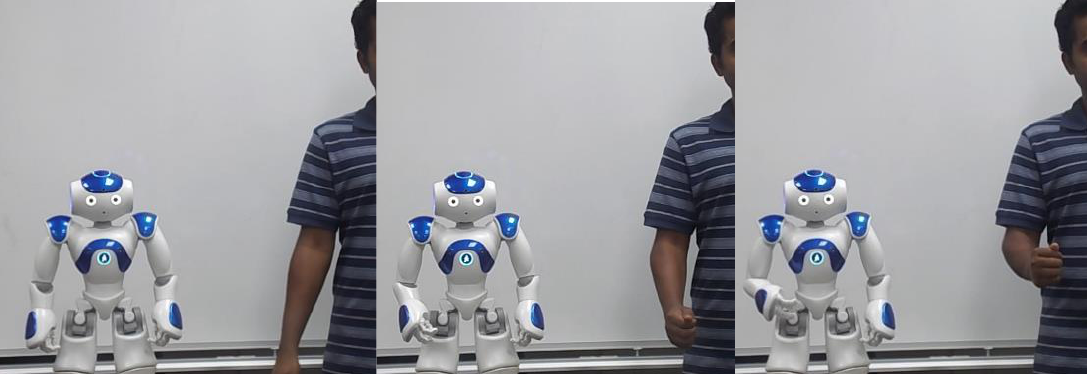
Figure 13: Arm position of human operator and NAO robot during elbow joint flexion/extension motion during